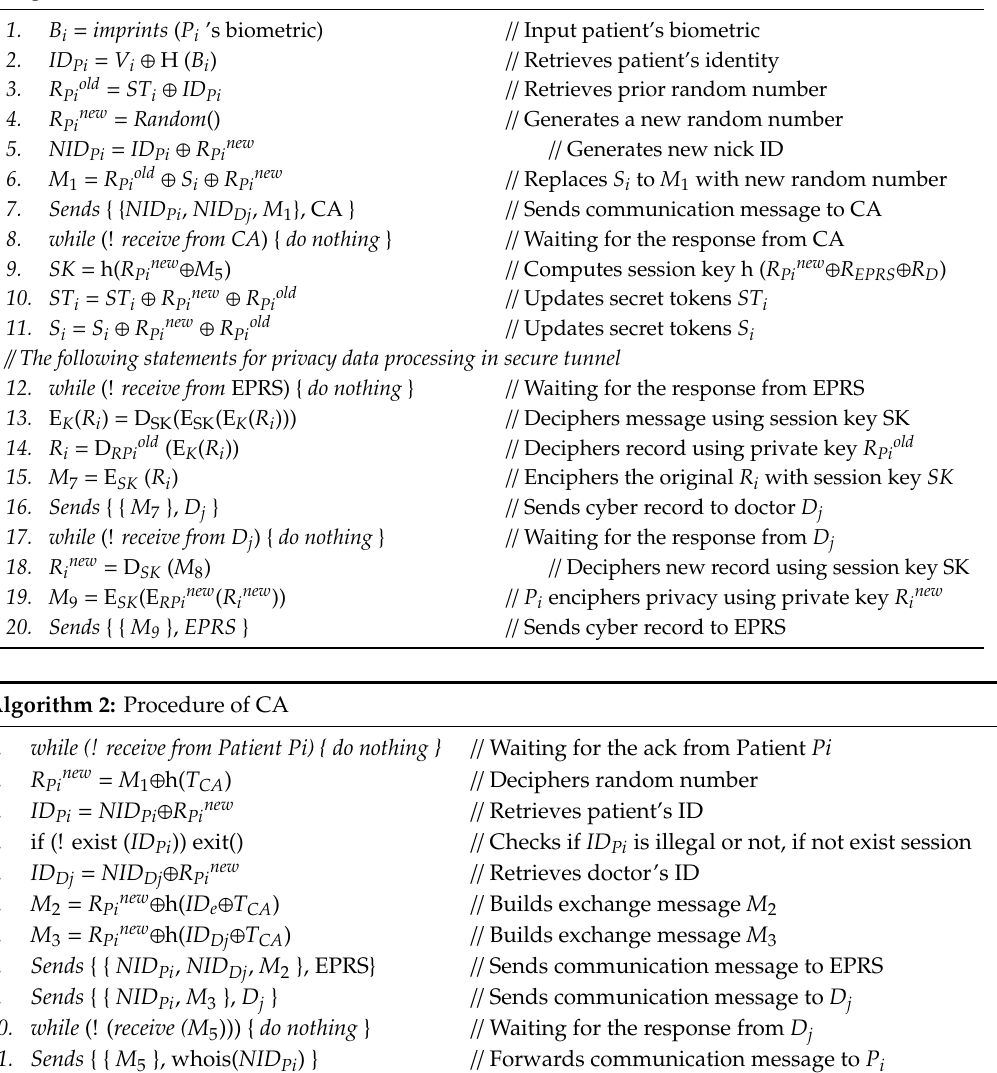
Algorithm 1: Procedure of Patient P i